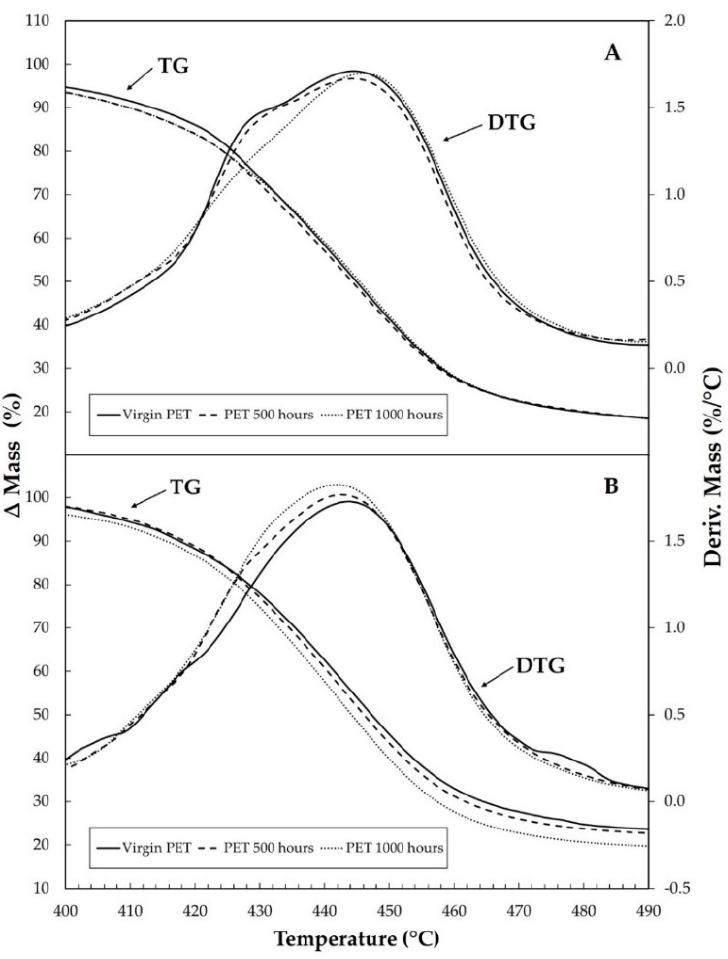
Figure 6. Details of TG/DTG curves of virgin PET, PET 500 h, and PET 1000 h under heating rates of 20 °C·min − 1 with flow of 100 mL min − 1 in α -alumina crucible: ( A ) under purge gas of synthetic air and ( B ) with purge gas of carbonic gas.